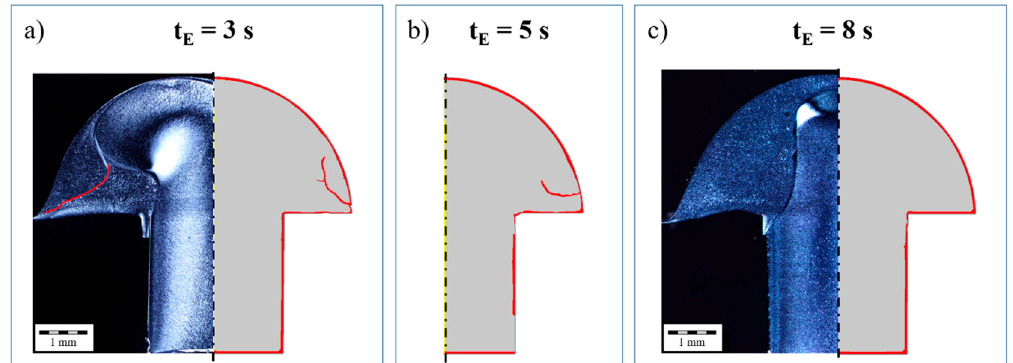
Figure 14. Numerical analysis—illustration of the emerging weld lines due to self-contact of melted areas during forming for different heating times t E as well as the comparison between numerical and experimental data, ( a ) t E = 3 s, ( b ) t E = 5 s, ( c ) t E = 8 s.